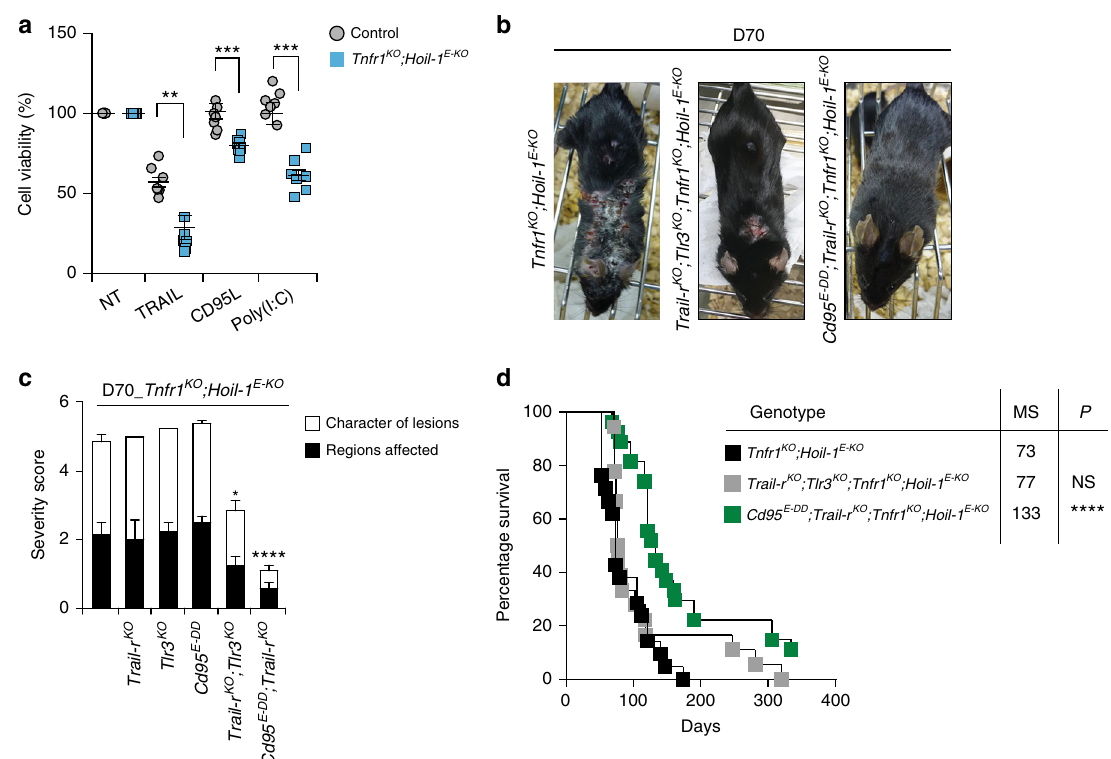
Fig. 8 TNFR1-independent dermatitis is induced by CD95L- and TRAIL-driven cell death. a PMKs derived from adult mice of the indicated genotypes were left untreated or treated for 24 h with TRAIL, CD95L or Poly(I:C). Data are presented as mean values ± s.e.m. ( n = 7 mice per genotype). ** P ≤ 0.01, *** P ≤ 0.001. Control mice represent a pool of Tnfr1 KO ;Hoil-1 fl / fl ;K14-Cre- and Tnfr1 KO ;Hoil-1 fl /wt ;K14-Cre + mice. b , c Representative images ( b ) and severity score of dermatitis ( c ) of mice of the indicated genotypes assessed at D70. Tnfr1 KO ;Hoil-1 E-KO ( n = 6), Trail-r KO ;Tlr3 KO ;Tnfr1 KO ;Hoil-1 E-KO ( n = 20) and Cd95 E-DD ;Trail- r KO ;Tnfr1 KO ;Hoil-1 E-KO ( n = 19), * P ≤ 0.05, **** P ≤ 0.0001. d Kaplan – Meier survival curve of mice with the indicated genotypes. Comparisons between Tnfr1 KO ;Hoil-1 E-KO mice with mice with the indicated genotypes were submitted for statistical analysis. MS: median survival. **** P ≤ 0.0001; NS: not signi fi cant. Tnfr1 KO ;Hoil-1 E-KO ( n = 21), Trail-r KO ;Tlr3 KO ;Tnfr1 KO ;Hoil-1 E-KO ( n = 21) and Cd95 E-DD ;Trail-r KO ;Tnfr1 KO ;Hoil-1 E-KO ( n =